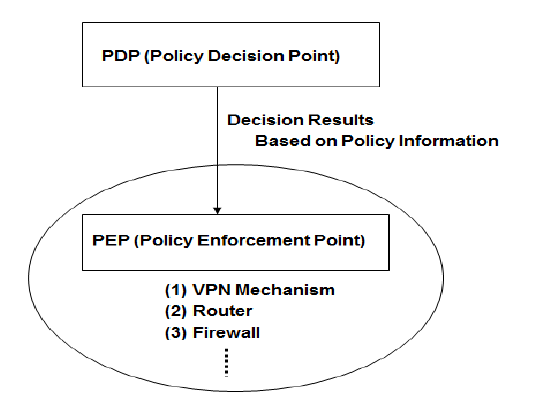
Figure 2. Essential